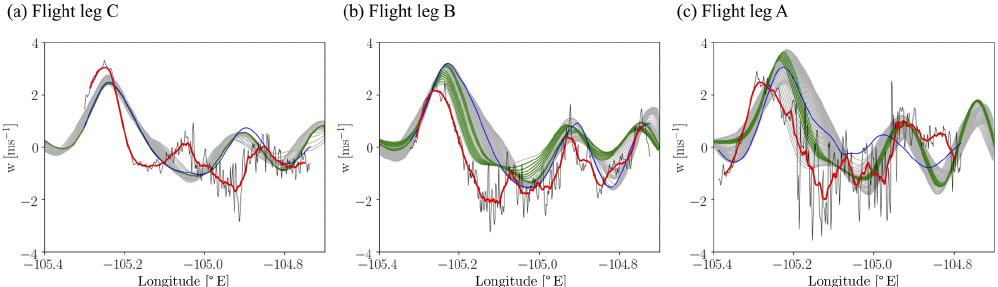
Figure 3. Vertical velocity along (a) flight leg C (7680m, 21:20UTC), (b) flight leg B (7200m, 21:00UTC), and (c) flight leg A (6900m, 20:40UTC). The red solid line shows the aircraft data smoothed with a 20s moving average filter (full 1Hz data shown by the thin black line). The blue line shows the modelled aircraft velocity interpolated to the aircraft track. The grey lines show the vertical velocity along tangents to the mean streamline (including a deviation corresponding to the deviation between the observed mean horizontal wind direction and the direction of the aircraft track), for which the peak vertical velocity exceeds 2.5ms − 1 . This threshold was chosen to focus on the centre of the wave cloud only. The green line shows the tangent for which the Pearson correlation (including a lag of ± 20s) with the observed vertical velocity is larger than 0.95. To account for the temperature bias of the model, model data are taken 200m above the altitude of the flight track.